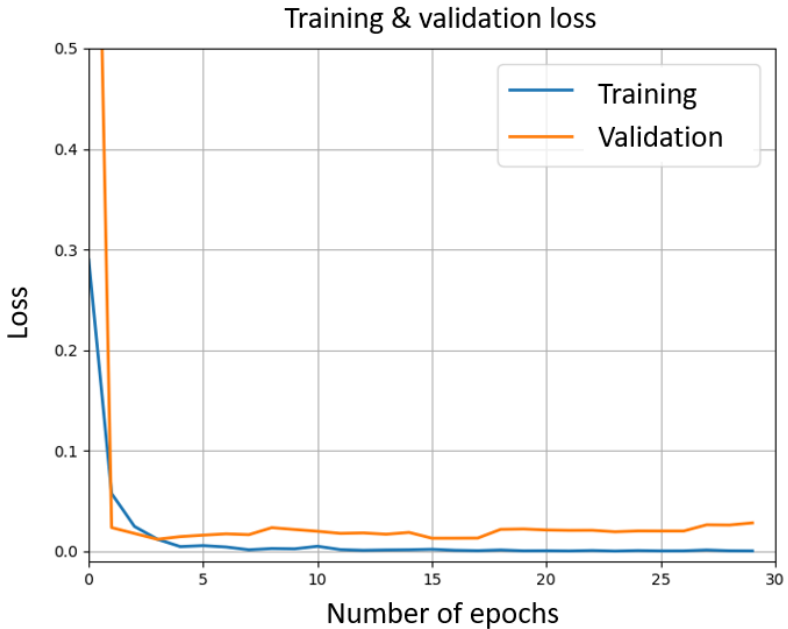
Figure 4. Training (blue) and validation (orange) loss through epochs for the CNN.